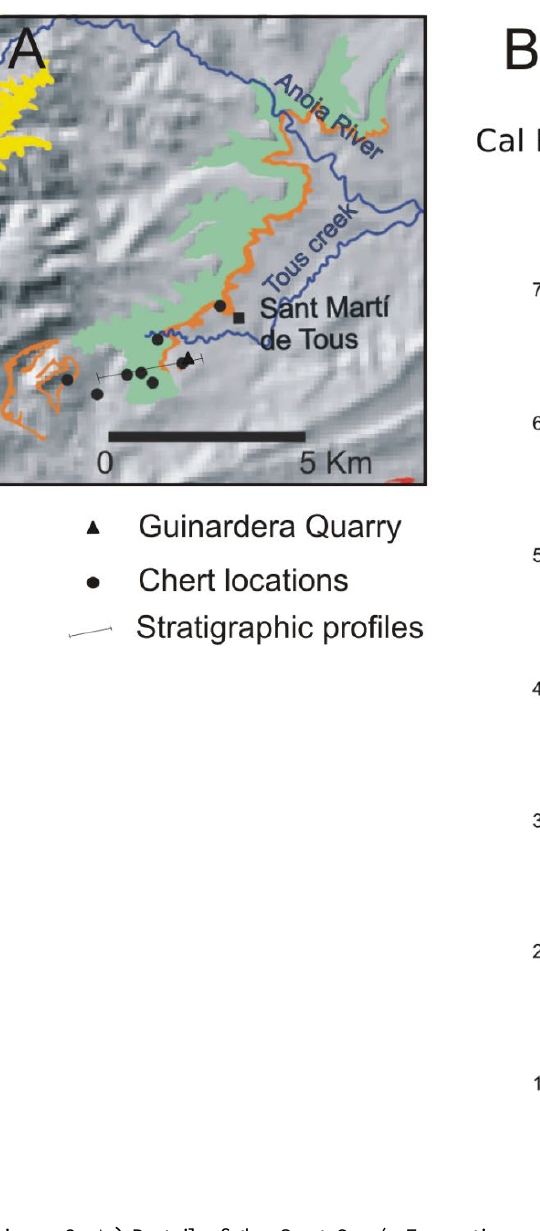
Figure 3. A) Detail of the Sant Genís Formation and the location of the Guinardera Quarry. B) Synthetic lithostratigraphic sequence of the Sant Genís Formation in the Guinardera Quarry and the stratigraphic position of the different located chert layers (synthetic stratigraphic sequences by B. Gómez de